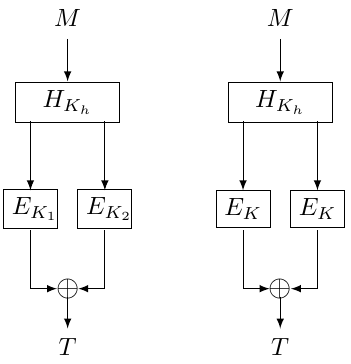
Figure 3.1: Two different types of Double block Hash then Sum constructions. Left